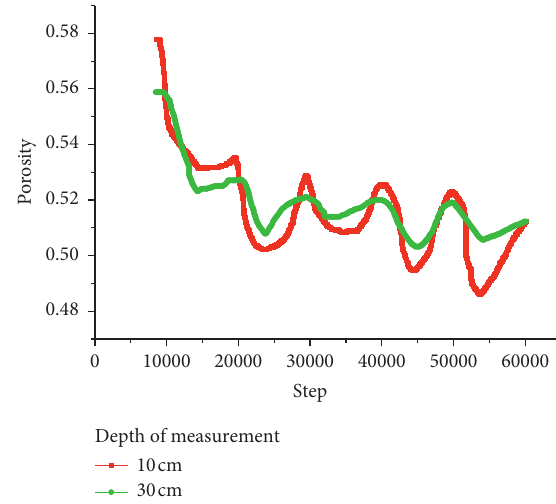
Figure 26: Curve of porosity change of 70cm thick reclaimed soil with five compactions.